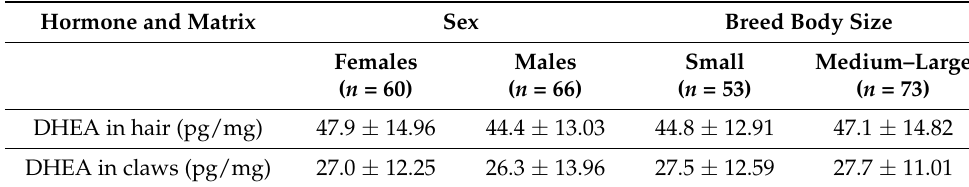
Table 1. Data (mean ± SD) about the hair and claw DHEA concentrations in the 126 puppies, grouped according to sex and breed body size. Hormone and Matrix